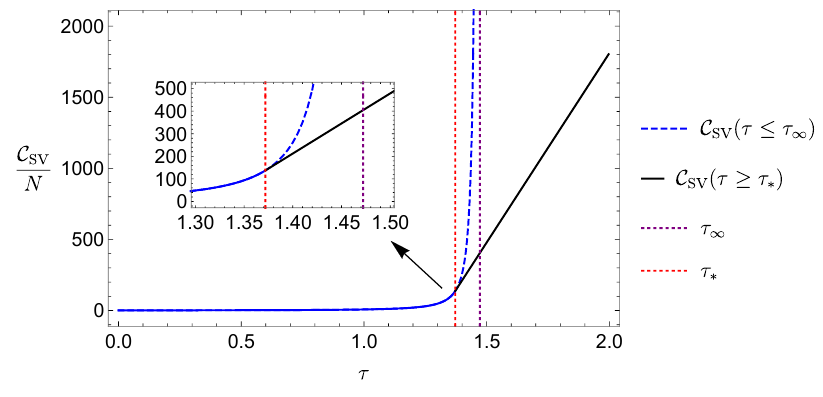
Figure 7 . The time evolution of holographic complexity from spacetime volume C blue curve denotes the holographic complexity before the critical time, i.e., C introducing the cut-off surface, holographic complexity C black line. Here we choose d = 3 , ρ = 9